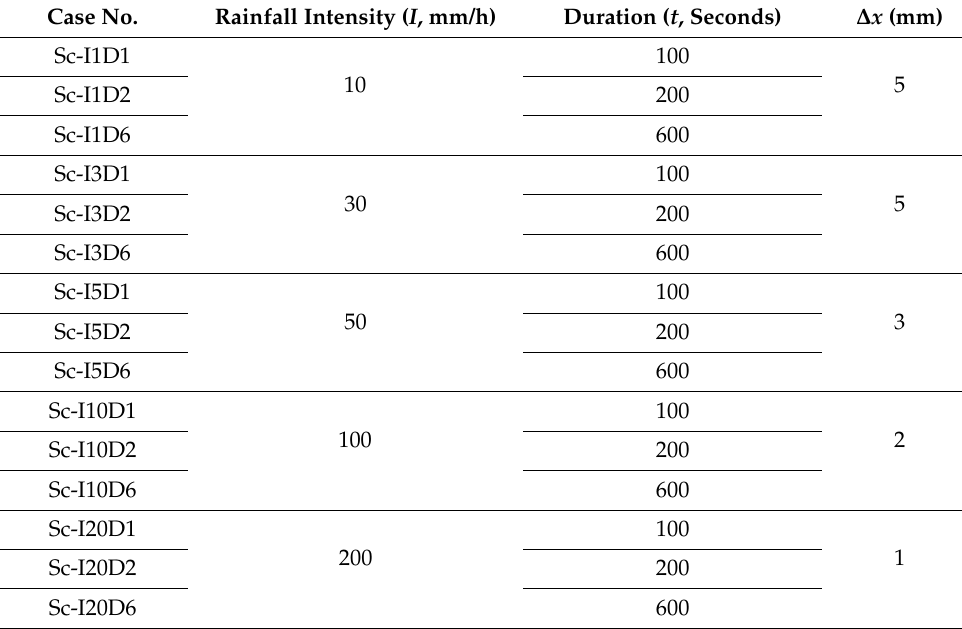
Table 3. Boundary conditions of scaled